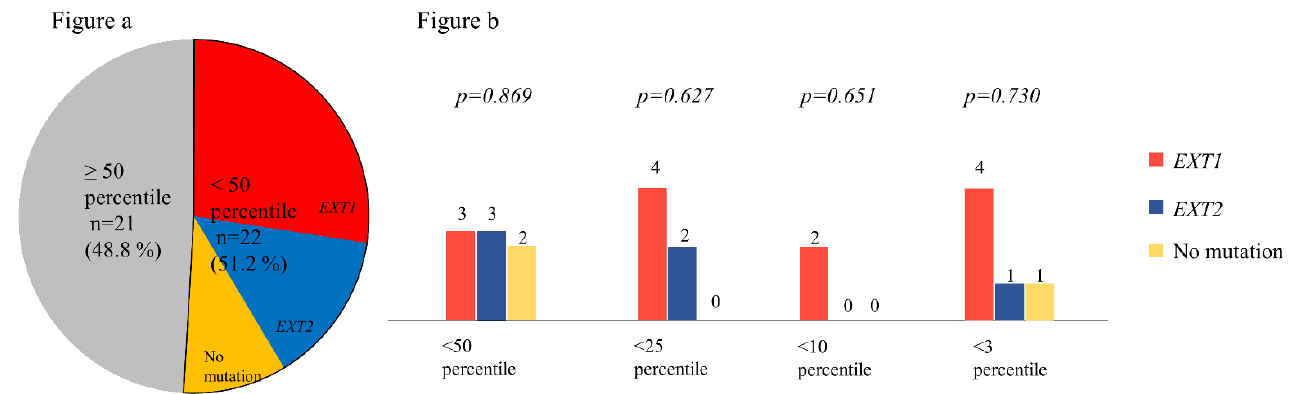
Figure 6. ( a ) Distribution of height percentile according to the gene mutation. The proportions of patients with EXT1 mutations were higher than those with EXT2 or no mutations among patients with below the 50th percentile of height. ( b ) Distribution of patients in different percentiles of height. There was no significant difference according to the gene mutation.